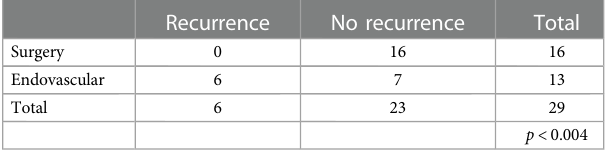
TABLE 2 Recurrence rate: Dural AVF (number of treatment).